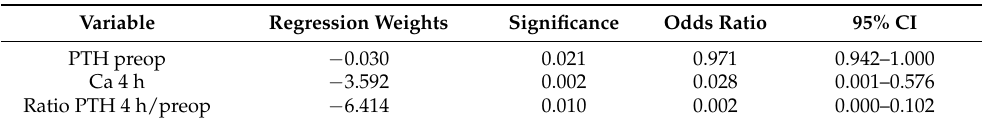
Table 3. Parameters retained in the model as significant in the binary logistic regression with the Forward Likelihood Ratio